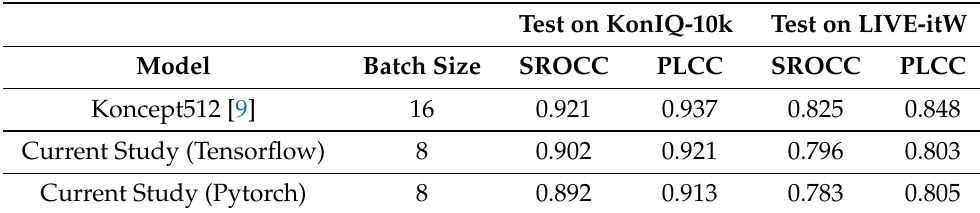
Table 3. Trained model with update version, and PyTorch version of authors compared to the original pre-trained model KonCept512.